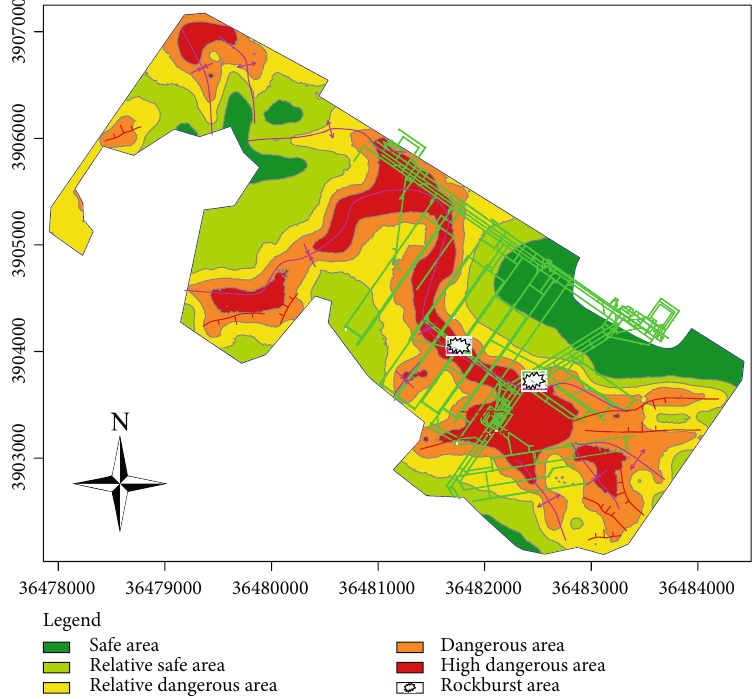
Figure 5: The zoning map of rockburst risk based on FAHP method.